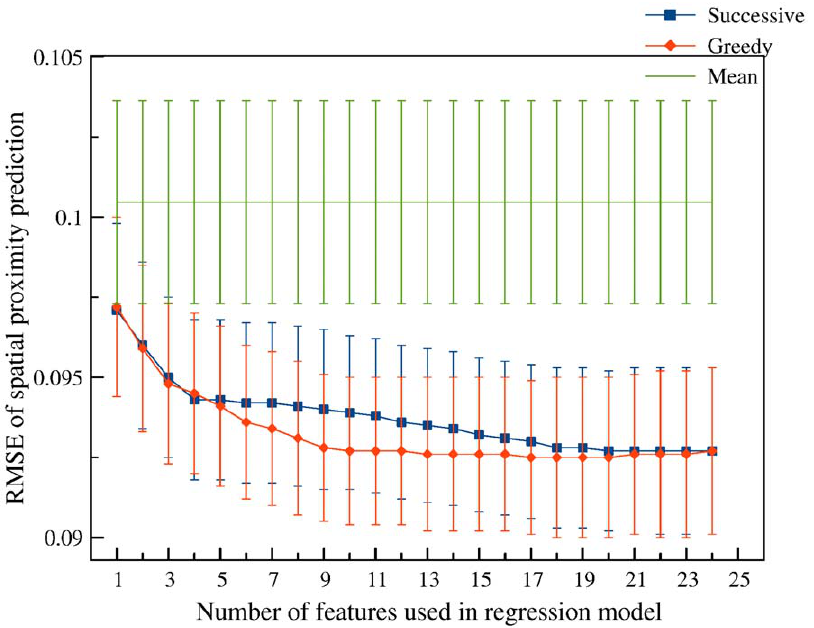
Figure 9. The root mean squared error (RMSE) of the spatial proximity prediction with standard deviations (SD) (all values were estimated on the testing set for each split and averaged) of regression models, which used one through 24 features, selected by two algorithms: Successive (successive selection based on individual accuracy) and Greedy (greedy forward feature selection), and the RMSE with SD of an algorithm, which always uses the training set mean as the predicted value. Additional information about used features can be found in Table S1.